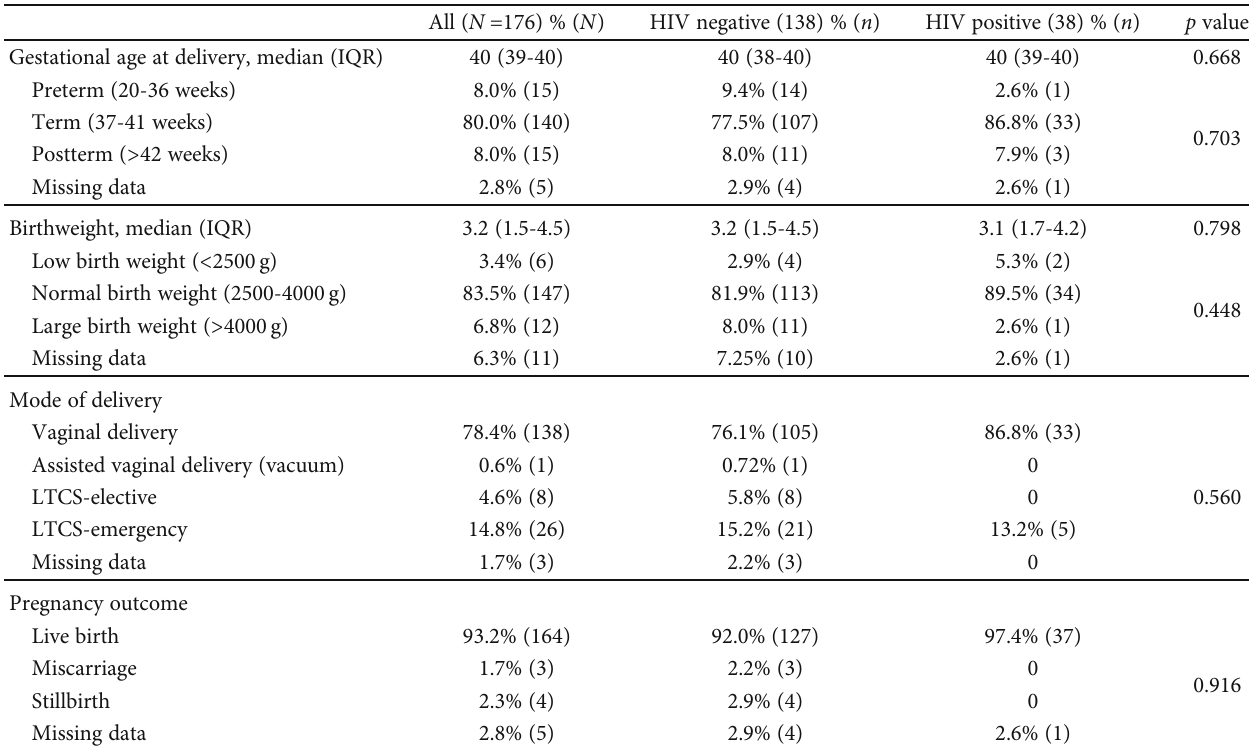
Table 4: Birth and obstetric outcomes, amongst all n = 332 that have visit 4